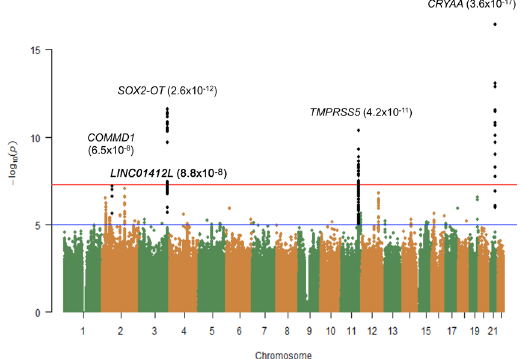
Fig. 1 Manhattan plot of the GWAS meta-analysis for age-related nuclear cataract in the combined analysis ( N = 14,151). The plot shows − log10- transformed P values for all SNPs; the upper horizontal line represents the genome-wide signi fi cance threshold of P < 5.0 × 10 − 8 ; the lower line indicates a P value of 10 − 5 . Data of both directly genotyped and imputed SNPs are presented in the Manhattan